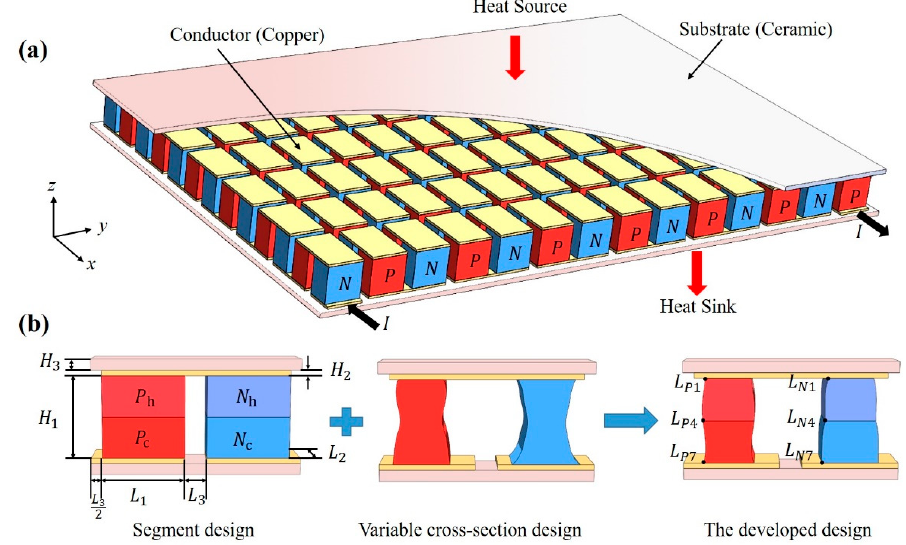
Figure 1. ( a ) Schematic diagram of the thermoelectric module and ( b ) Structure of the unit and the new design concept.